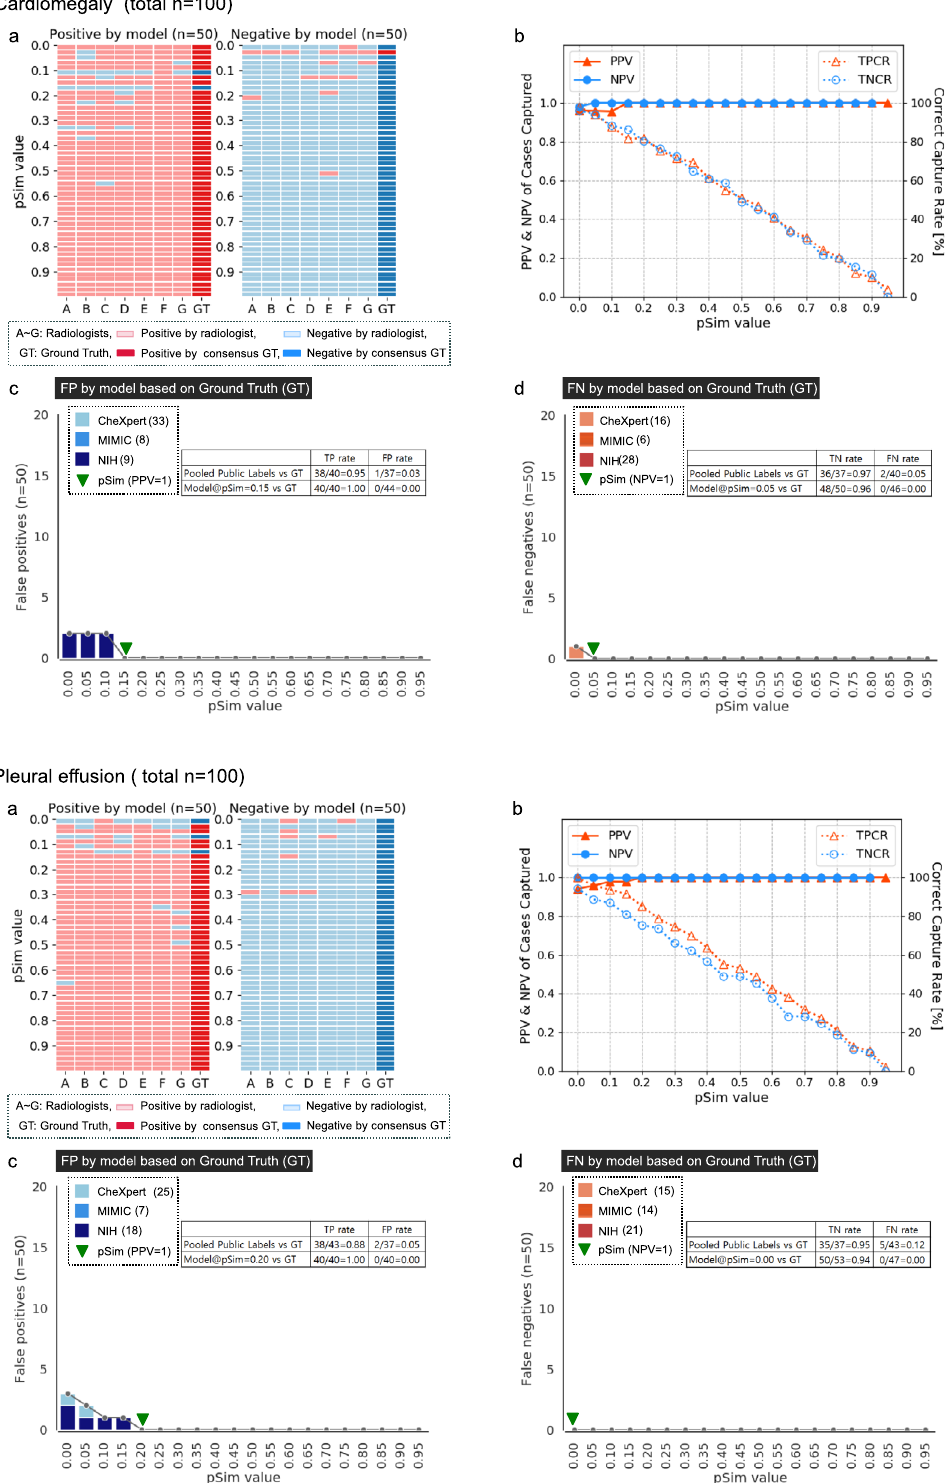
indicated. Of note, the lowest possible pSim threshold required for 100% PPV or NPV, corresponds to the maximal “ correct capture rate ” , as shown in Figs. 2 – 4b. Also, as shown in the text boxes in Figs. 2 – 4c, d, as well as in Fig. 5, model accuracy compared favorably to that of the available pooled public labels of the external, open-source datasets. Figure 5 additionally shows that the automated-labeling model ’ s AUROC